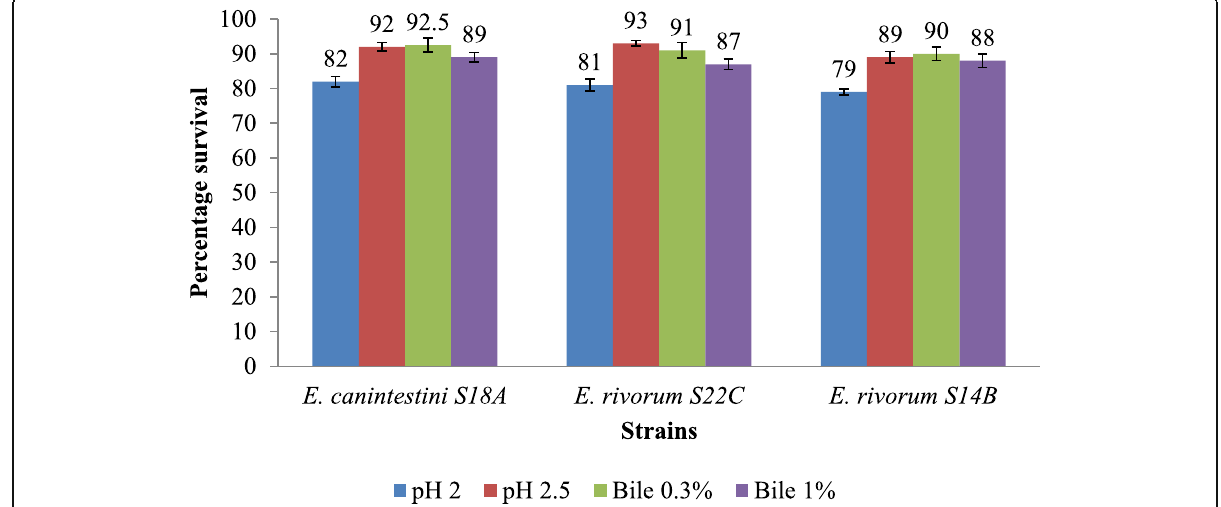
Fig. 1 Effect of acid (pH 2 and pH 2.5) and bile (0.3% and 1%) on survival ability of spray-dried Enterococcus strains after 4